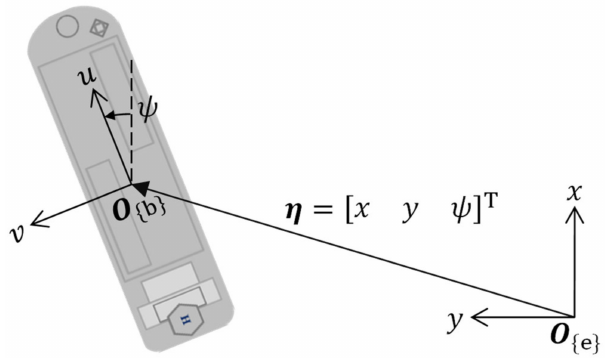
Figure 2. Coordinate systems: global reference frame { e } and the body-fixed coordinate { b